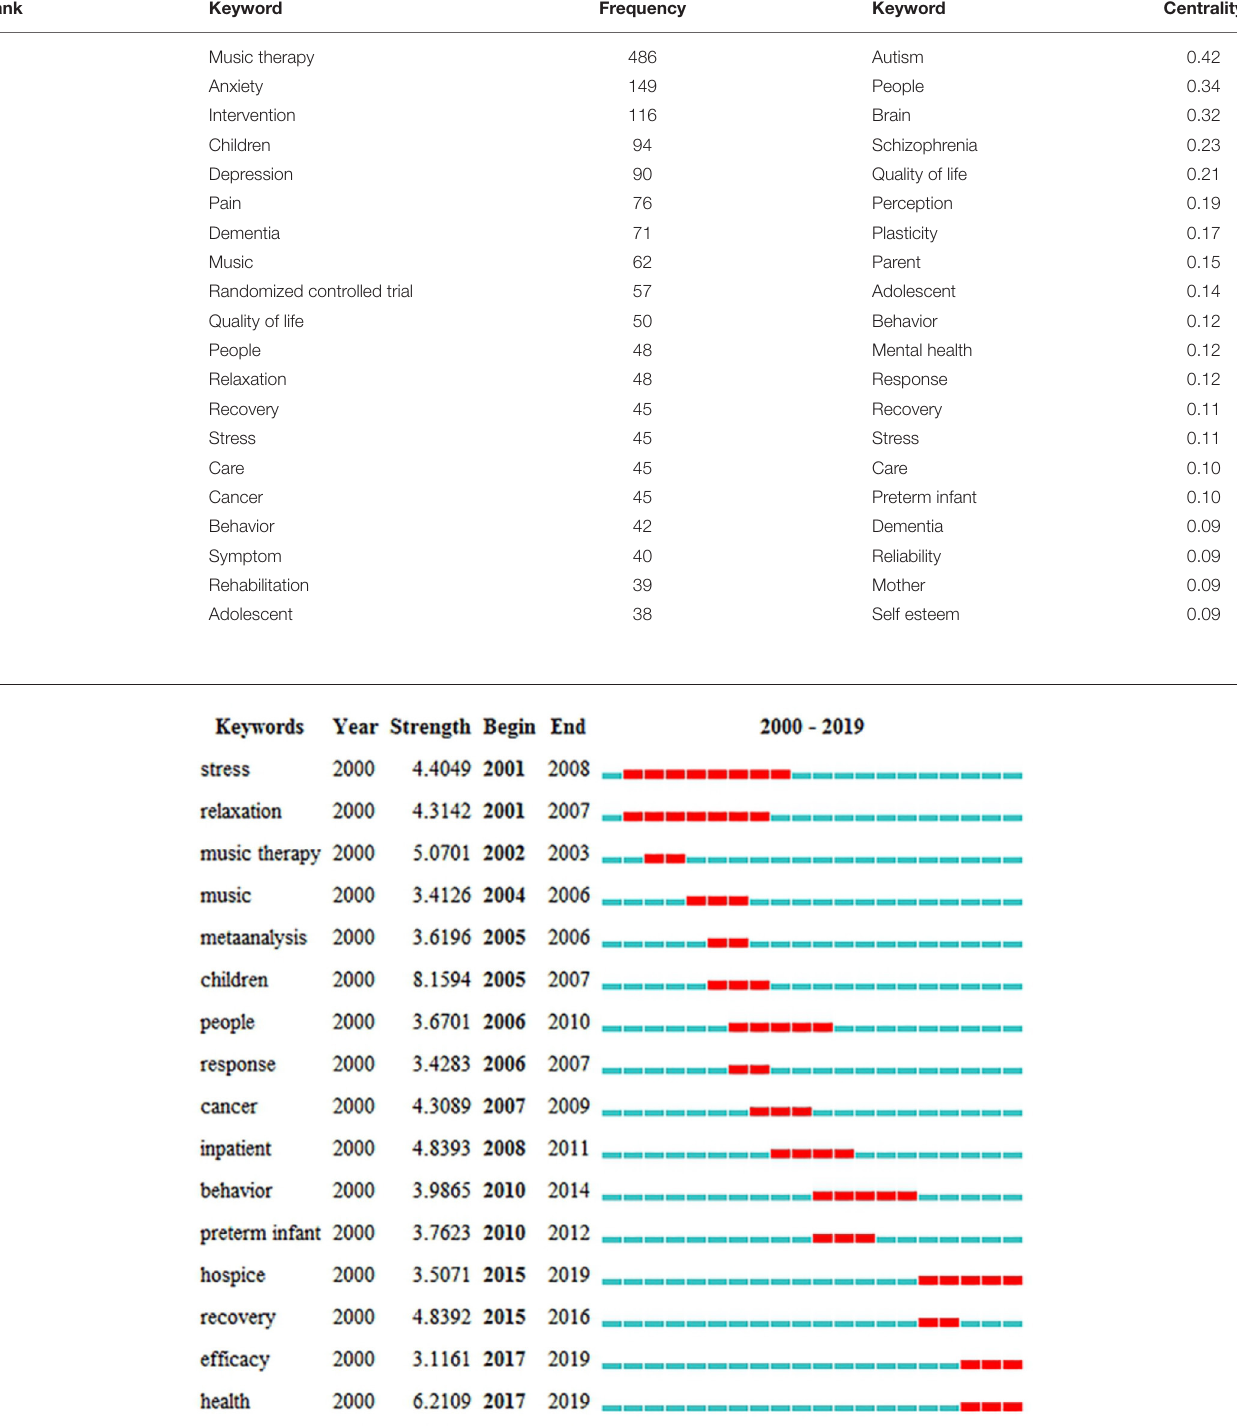
Frontiers in Psychology |